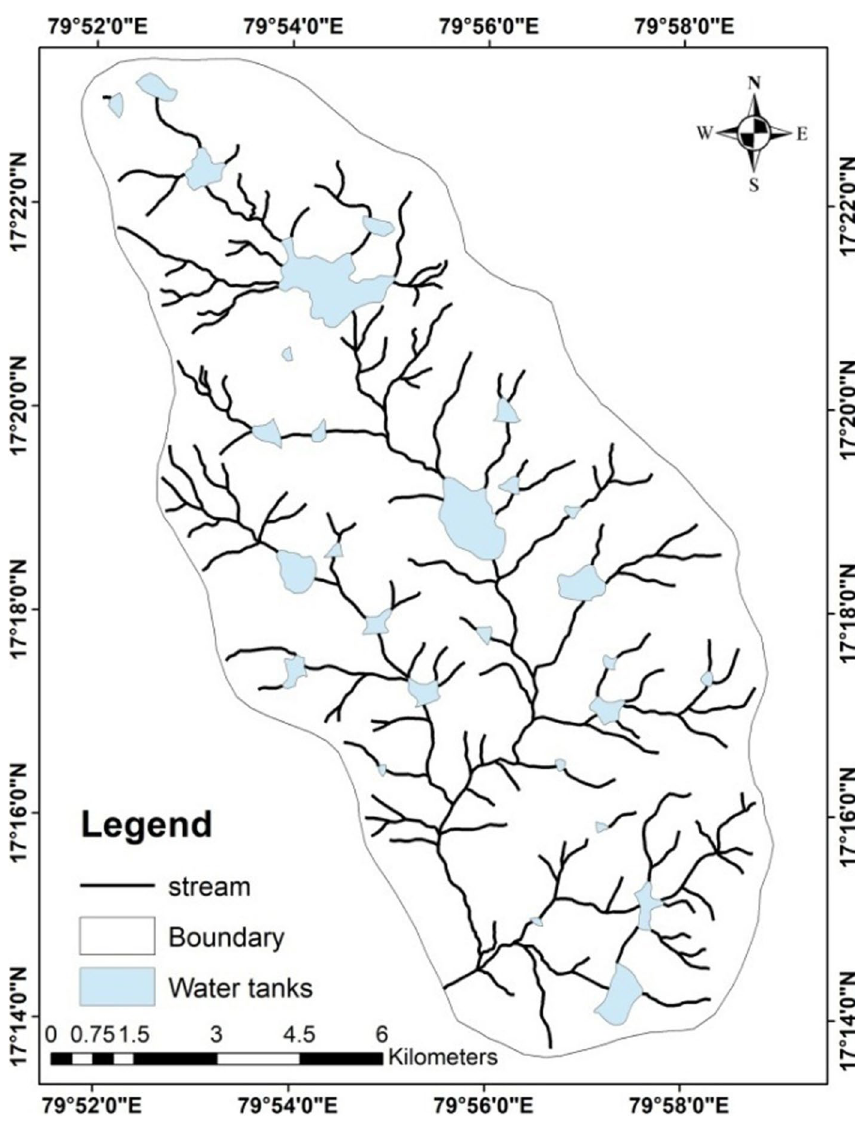
Fig. 4 Drainage map of the Subledu